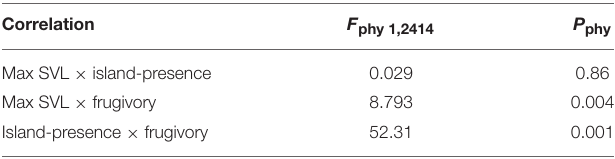
TABLE 4 | Phylogenetic independent contrasts ( PIC ) correlations between “max SVL,” “frugivory,” and “island-presence” of 2,417 lizard species, based on the phylogeny of Pyron et al. (2013).